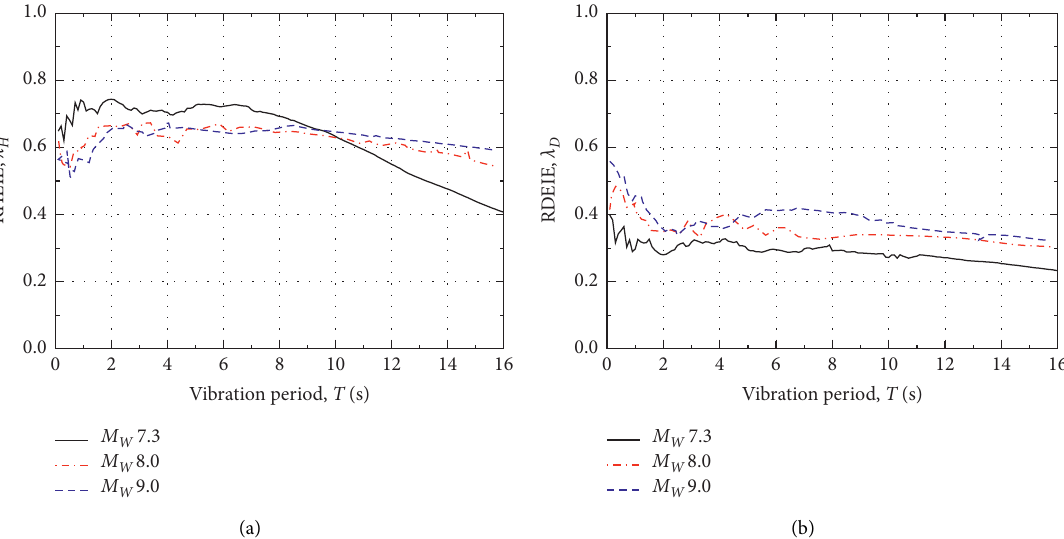
Figure 10: Energy distribution rule affected by earthquake magnitude under far-field harmonic ground motions. (a) RHEIE. (b) RDEIE.